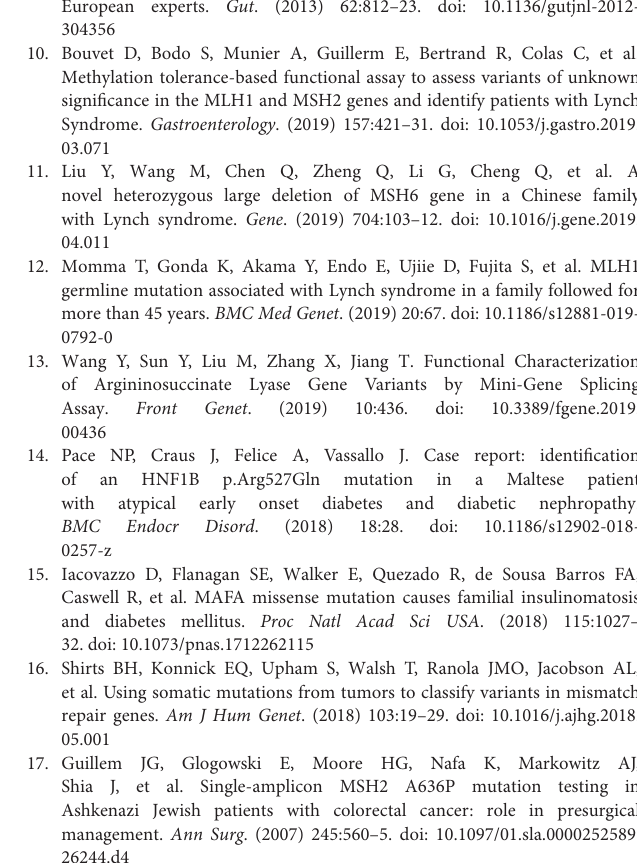
Supplementary Figure 1 | Family pedigree of the patient. squares, males; circles, females; slashs, died; black symbols, colorectal cancer, the proband (III-1). Supplementary Figure 2 | Electropherogram of the Sanger sequencing. (A) TT wild type; (B) TG heterozygote type. Supplementary Table 1 | Proband’s whole-exome sequencing in